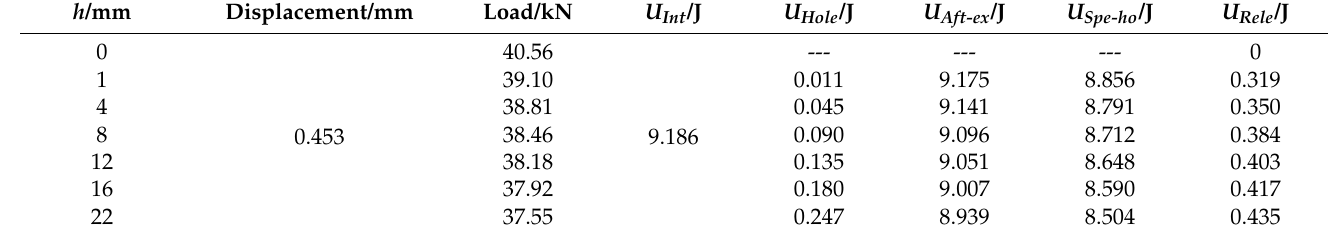
Table 5. The load of specimens with holes that have different height and strain energy in each part.